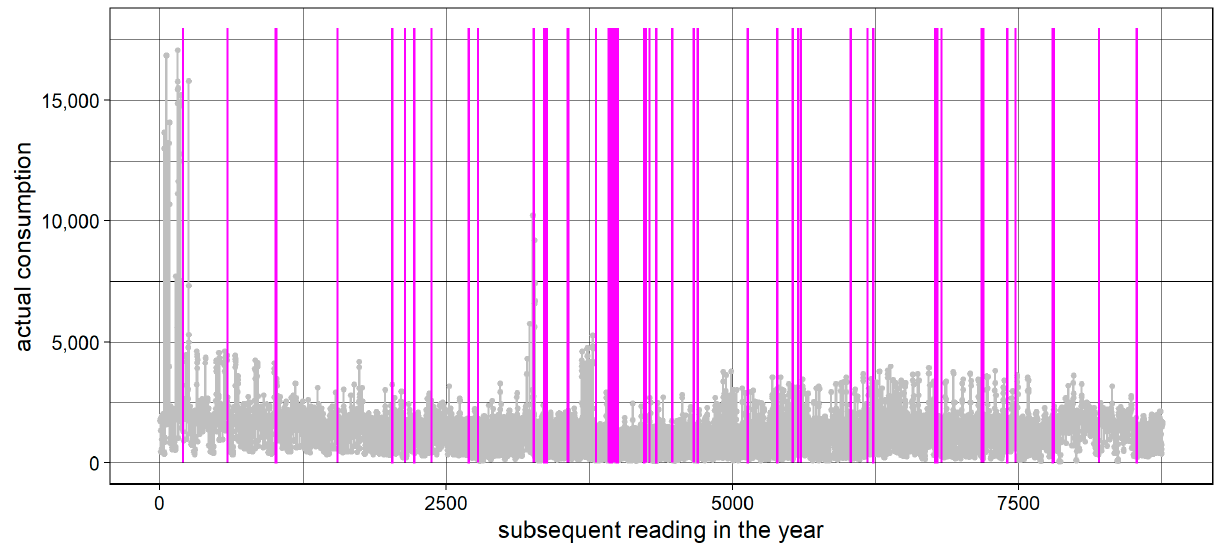
Figure 2. PPE-Example1—course of the series with marked missing data (103 missing values, 59 gaps, the longest sequence of missing values: 14). Source: own elaboration.